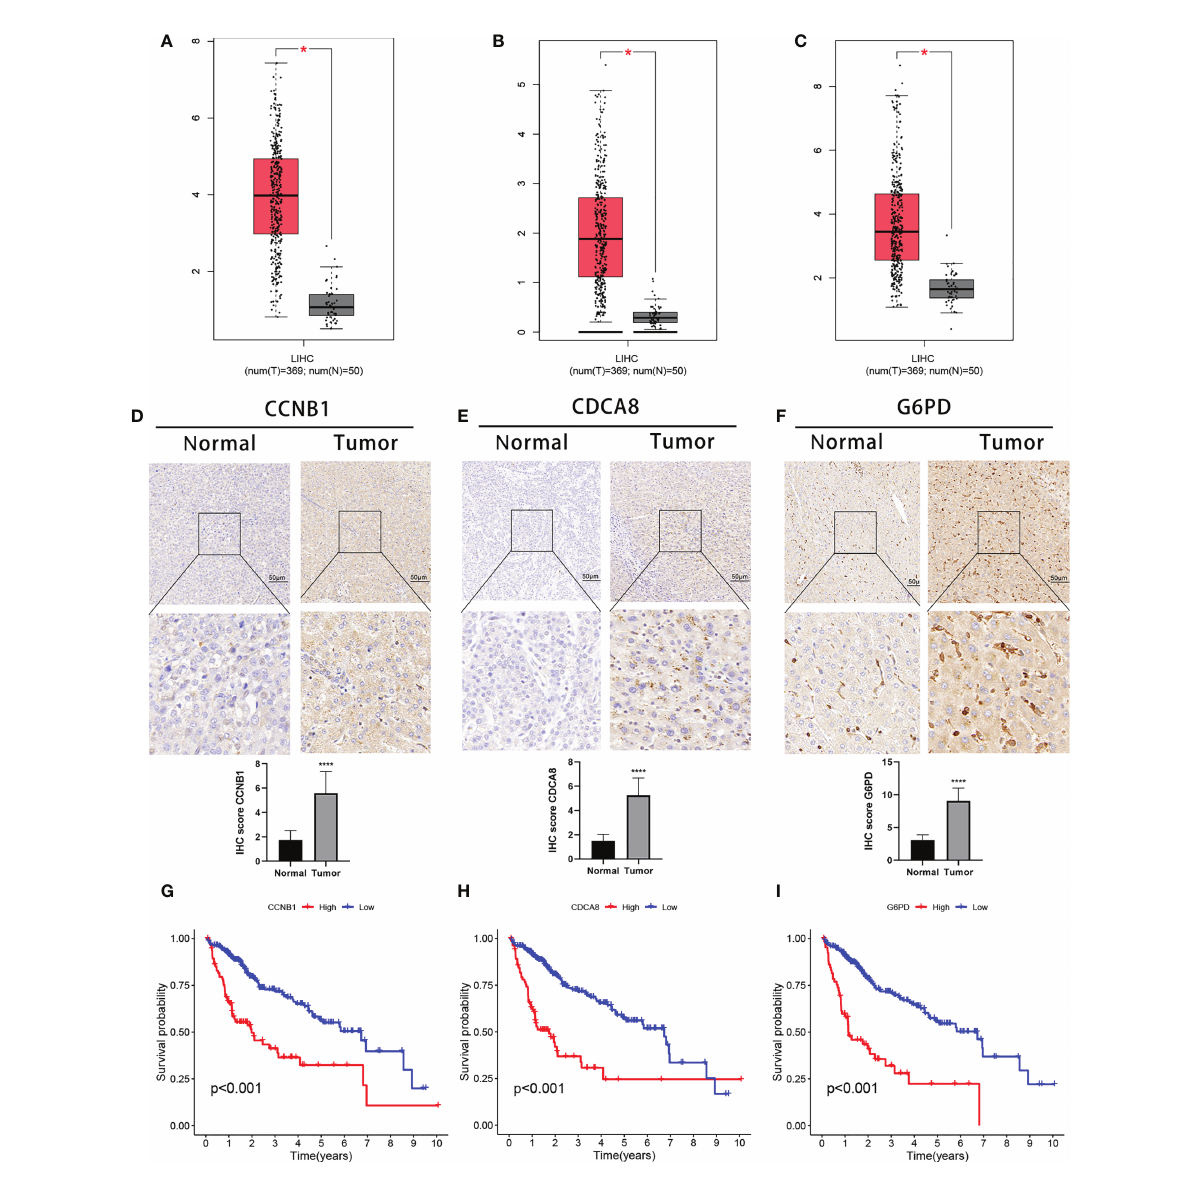
FIGURE 9 Expression of the three signature DEGs and their impact on prognosis. Expression of CCNB1 (A) , CDCA8 (B) , and G6PD (C) in tumor and normal samples (GEPIA). IHC analysis of CCNB1 (D) , CDCA8 (E) , and G6PD (F) expression in tumor and normal samples. K-M survival analysis between high- and low-expression groups of CCNB1 (G) , CDCA8 (H) , and G6PD (I) .*P < 0.05;****P < 0.0001. DEGs, differentially expressed